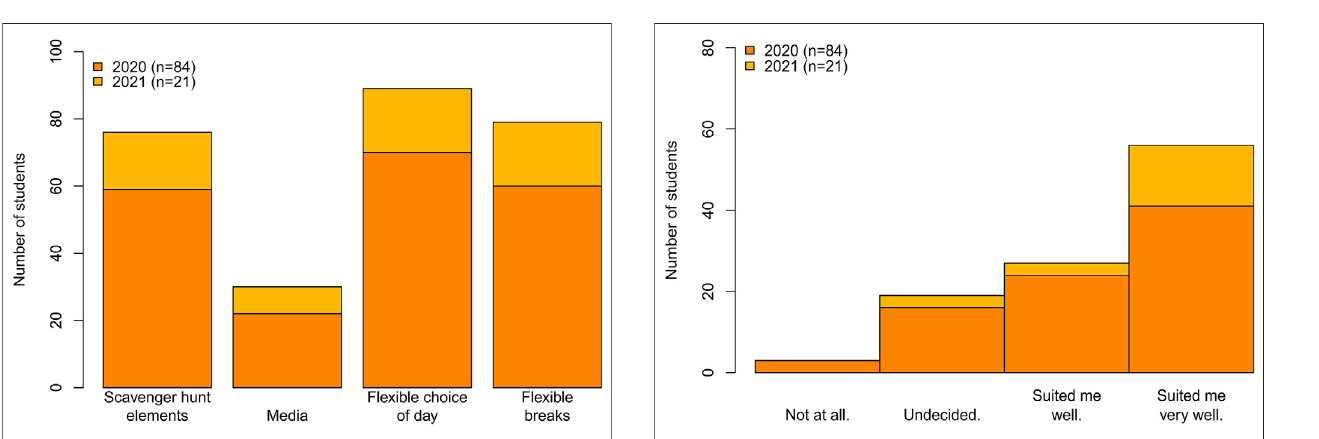
FIGURE2| Elementsoftheself-guided excursionthatstudentsratedas especially valuable. Most students appreciated the fl exibility and scavenger hunt elements of the self-guided excursion (results from the survey sent out directly after the excursion).